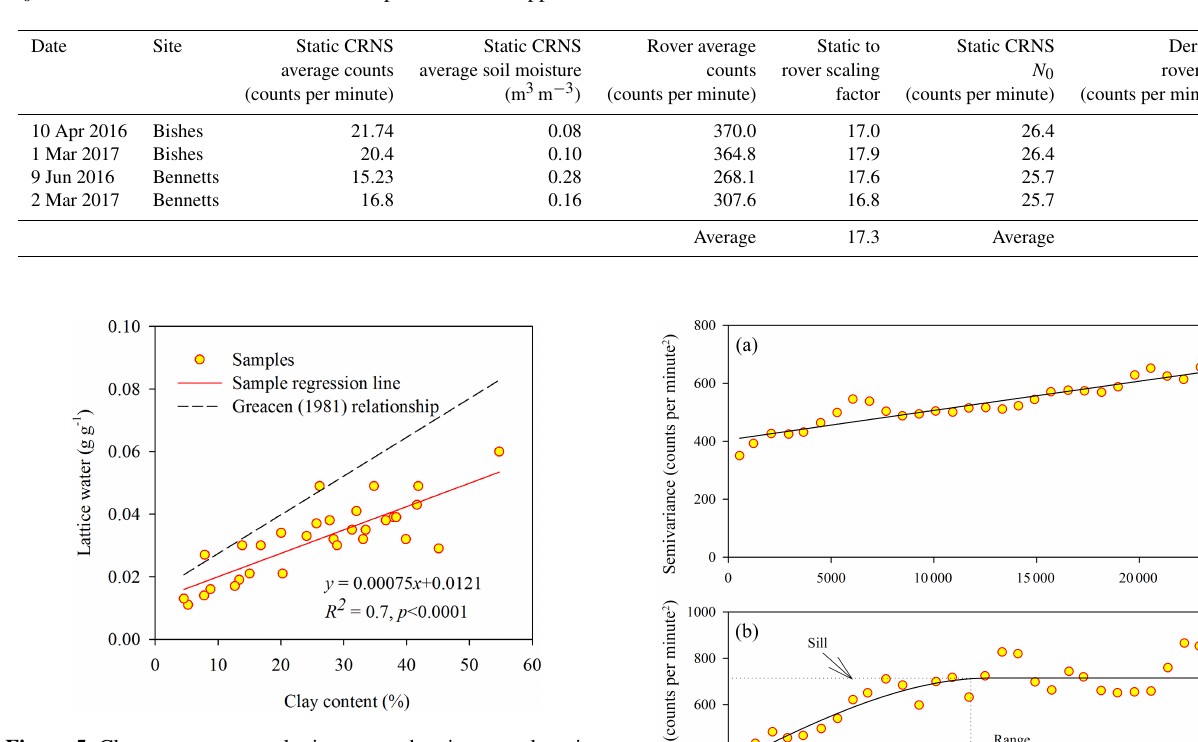
Figure 5. Clay content versus lattice water showing sample points from the study area and fitted relationship. Also shown for reference is the relationship proposed by Greacen (1981).